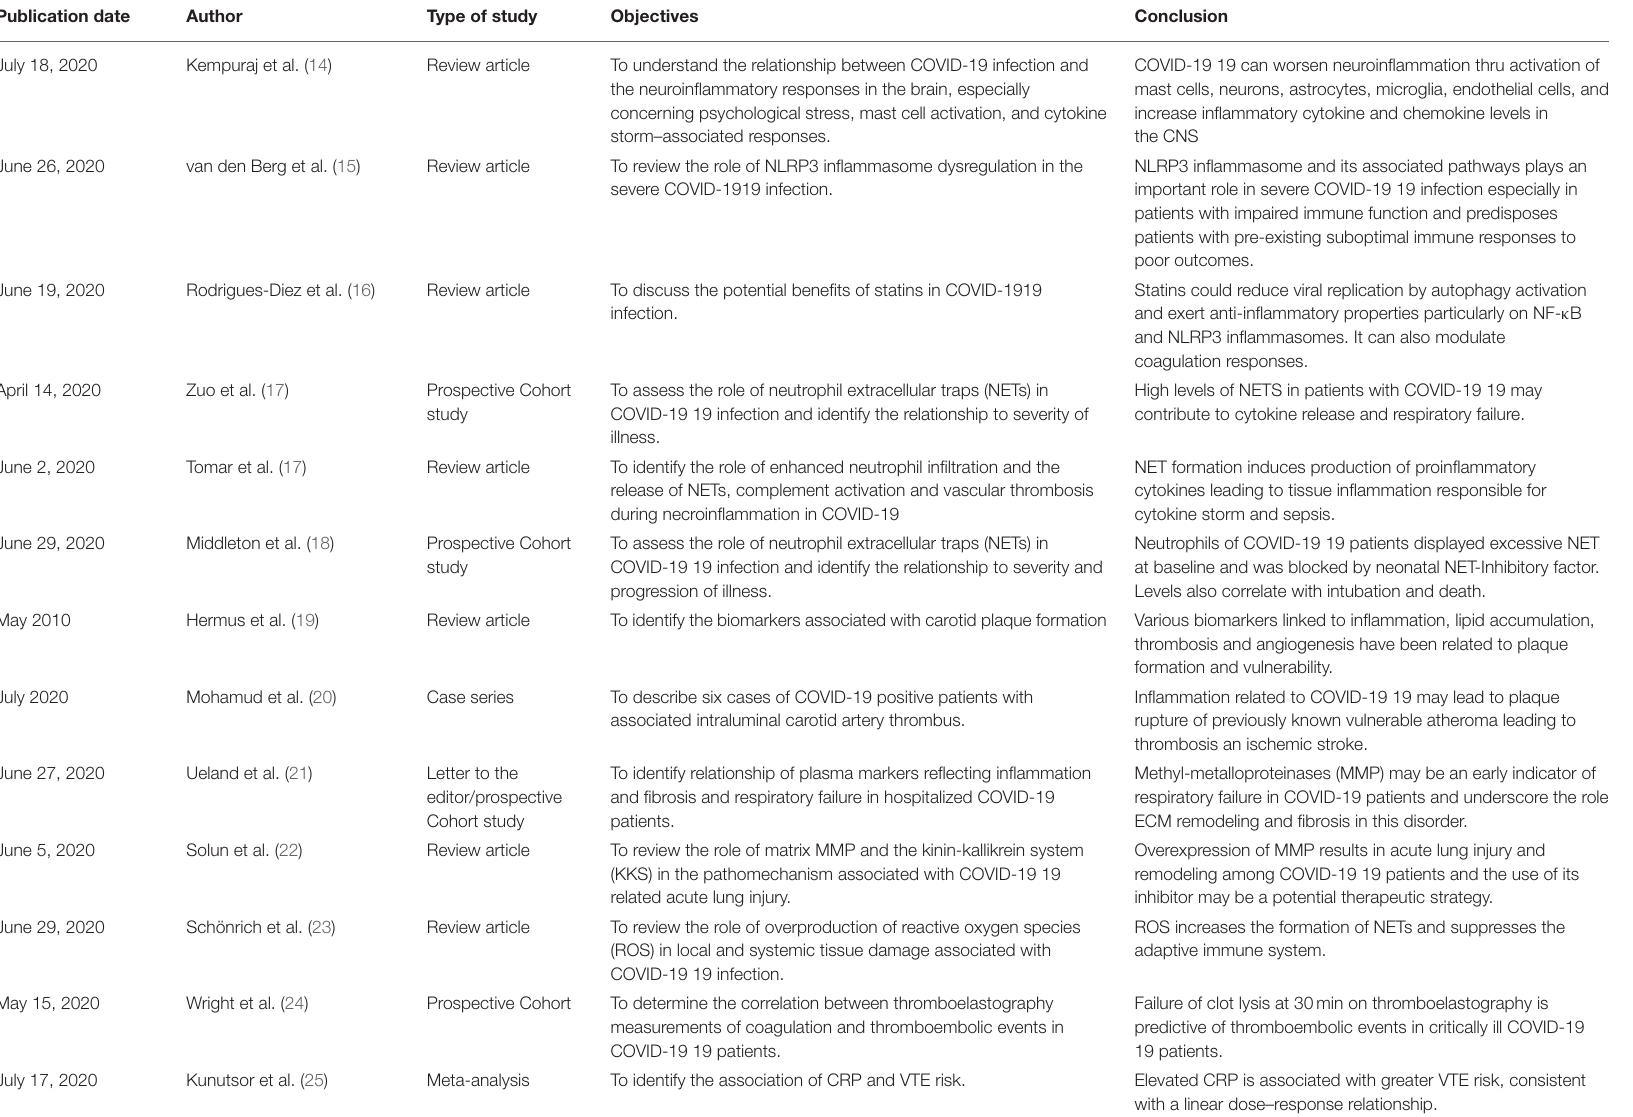
TABLE 1 | Summary of the main studies on the mechanisms of COVID-19-related